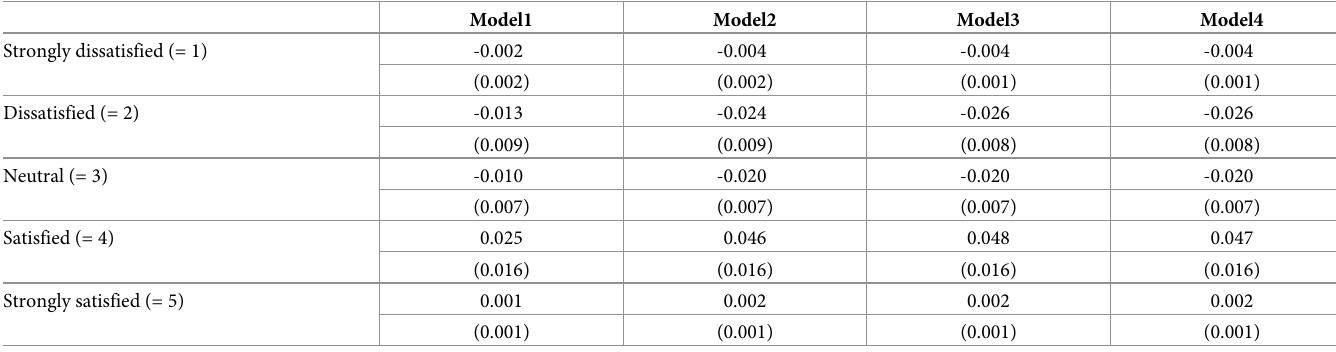
Table 4. Marginal effect of gender